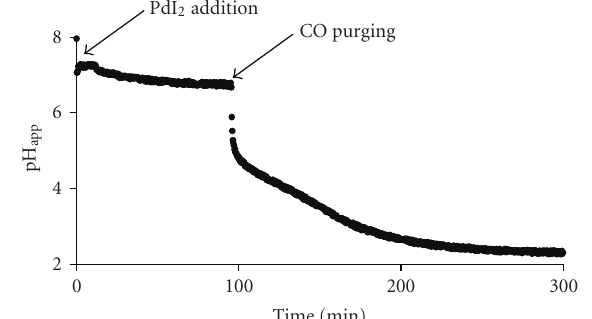
Figure 1: [KI] = 4.8 · 10 − 1 mol/dm 3 ; [PdI 2 ] if all dissolved = 2.66 · 10 − 3 mol/dm 3 ; CO flow = 6mL/min; 25 mL of